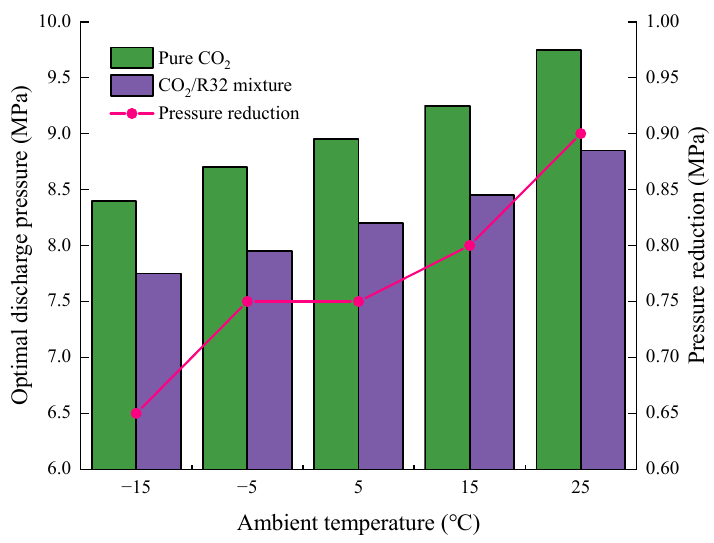
Figure 9. Comparison of the optimal discharge pressure with pure CO 2 and CO 2 /R32 mixture refrigerants at different ambient temperatures.